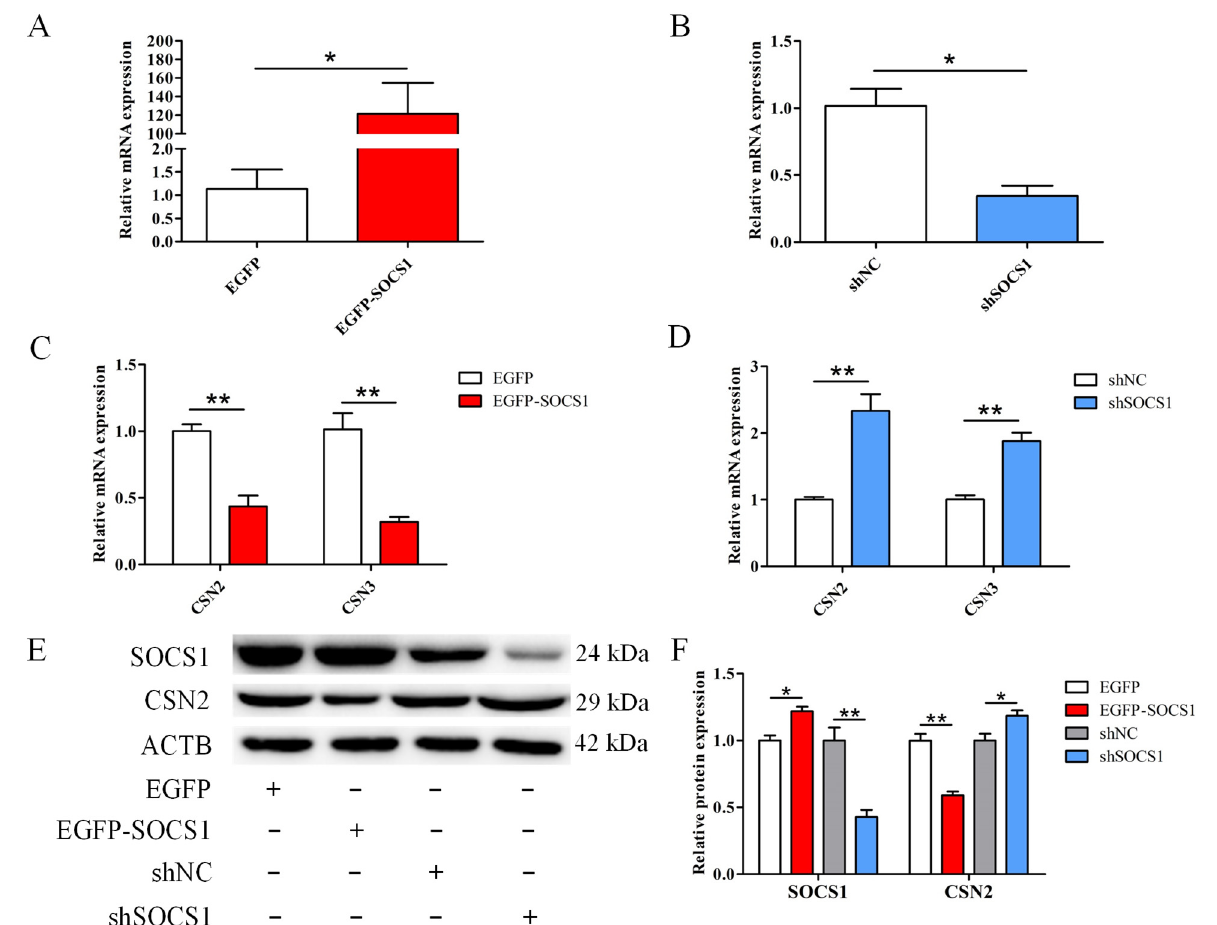
Figure 3. Effect of SOCS1 on milk protein synthesis in buffalo mammary epithelial cells (BuMECs). ( A , B ) The expressions of SOCS1 in BuMECs treated with the EGFP- SOCS1 , sh SOCS1 and corre- sponding negative controls (EGFP and shNC). ( C , D ) Effects of EGFP- SOCS1 or sh SOCS1 on the expression of CSN2 and CSN3 . ( E , F ) Effects of EGFP- SOCS1 or sh SOCS1 on the expression level of CSN2 protein. Data are presented as means ± SEM for three individual cultures; * p < 0.05, ** p < 0.01.